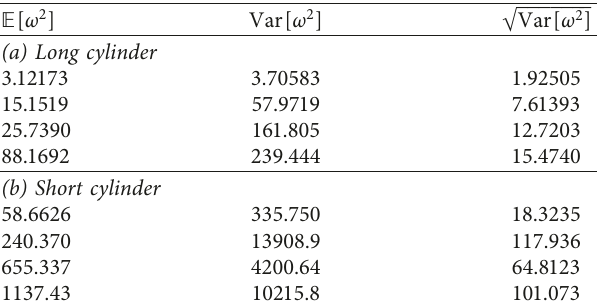
Figure 5: Shell configuration: t � 1/100; lowest mode; normalized transverse deflection w ; rainbow colour scale. (a) Long cylinder with T- junction and cone junction; frequency � 1Hz; x ∈ [ − 10 π , 10 π ] ; cone: [ 40 π /7 , 10 π ] . (b) Short cylinder with T-junction and cone junction; frequency � 10Hz; x ∈ [ − π , π ] ; cone: [ 4 π /7 , π ] . Table 4: Statistics of the four smallest eigenvalues of the long (a) and short (b) cylinder with junctions (solution computed with p � 3 and L � 2 (45 collocation points)).